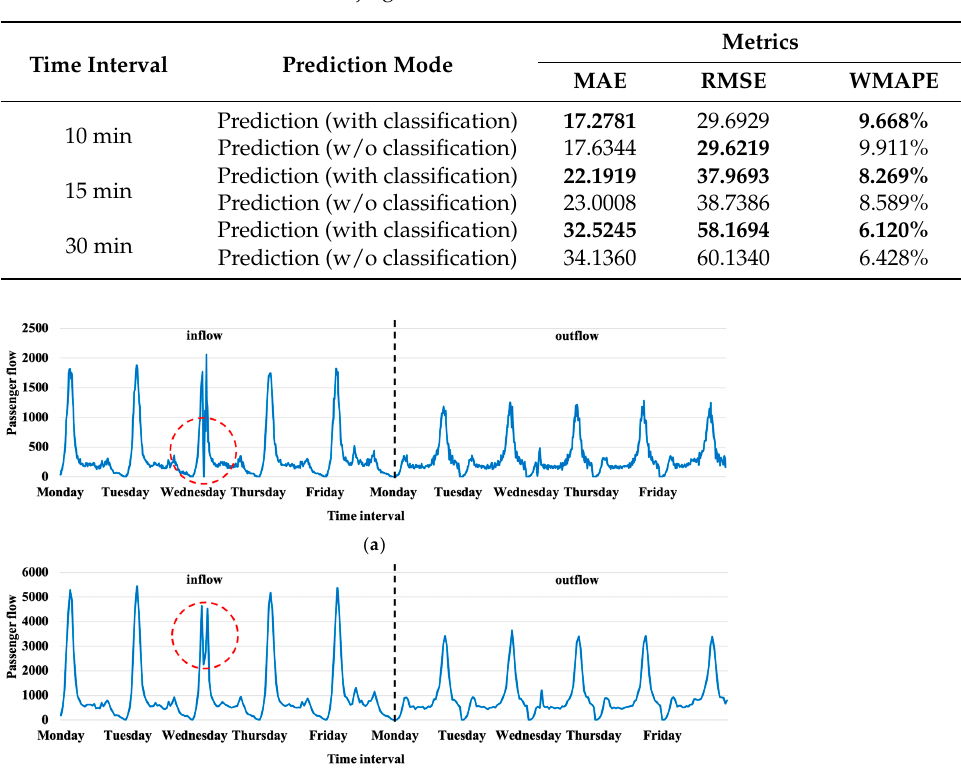
Table 8. Prediction results in the Beijing Metro.